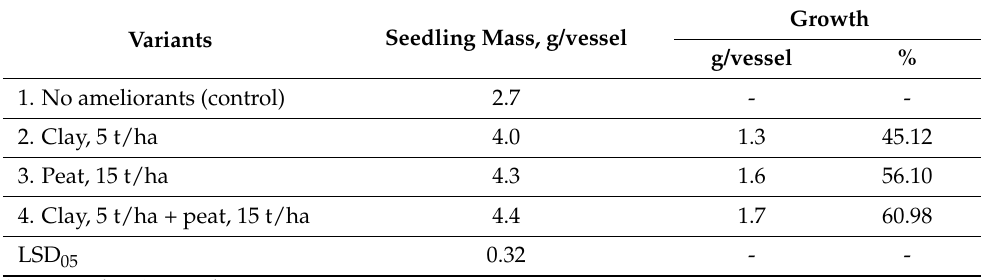
Table 2. Effects of structural ameliorants on the mass of barley seedlings on a sod-podzolic cohesive sandy soil (laboratory model experiment).